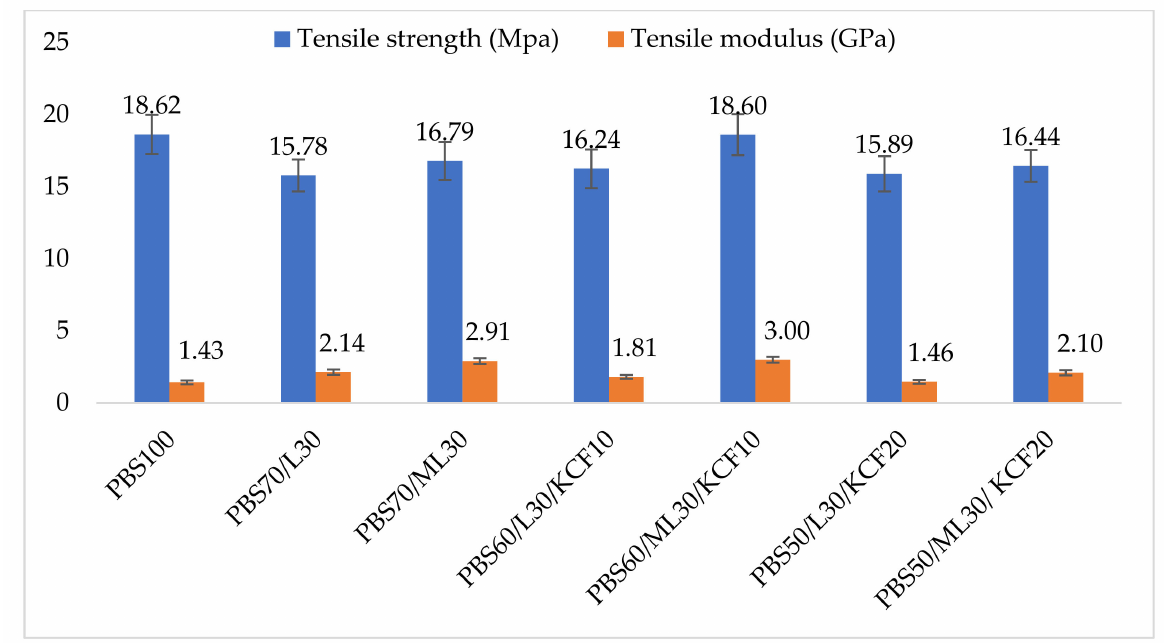
Figure 7. Tensile properties of PBS and its composites. Note: Poly (butylene succinate) (PBS), Lignin (L), Modified Lignin (ML), Kenaf Core Fiber (KCF).